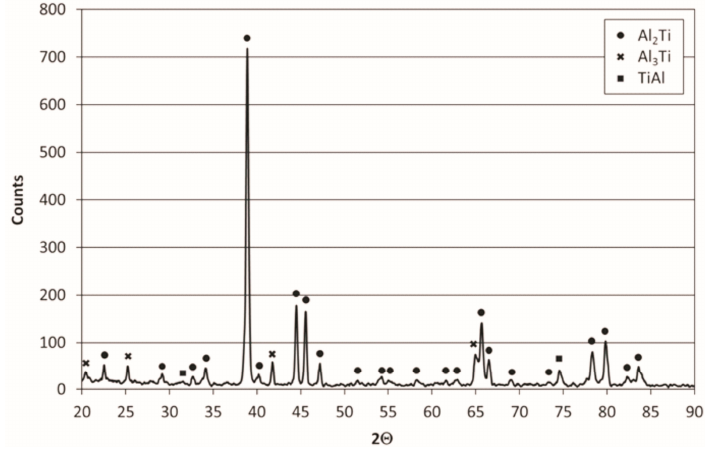
Figure 8. X-ray diffractograms of Ti–45Al–8Nb–0.5(B, C) alloy modified aluminium coating.